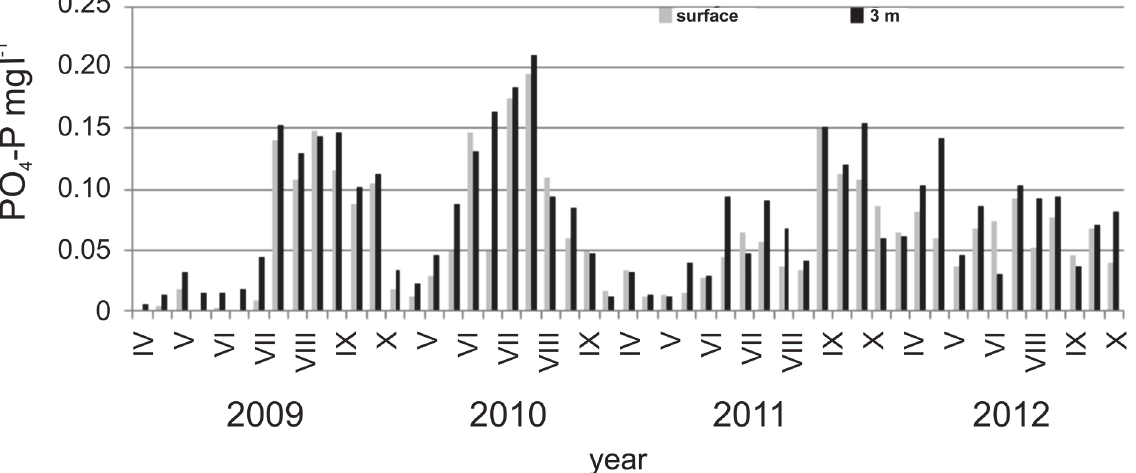
Fig 2. Concentration of phosphate phosphorus on the surface and the depth of 3m.